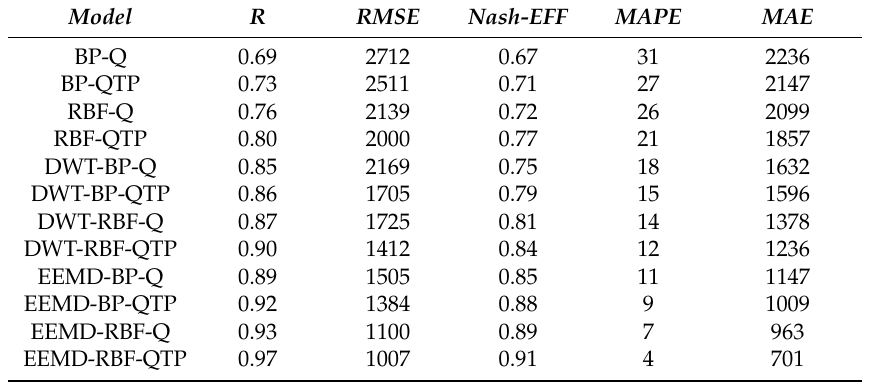
Table 10. Performance evaluation of the applied models for zone three during the calibration